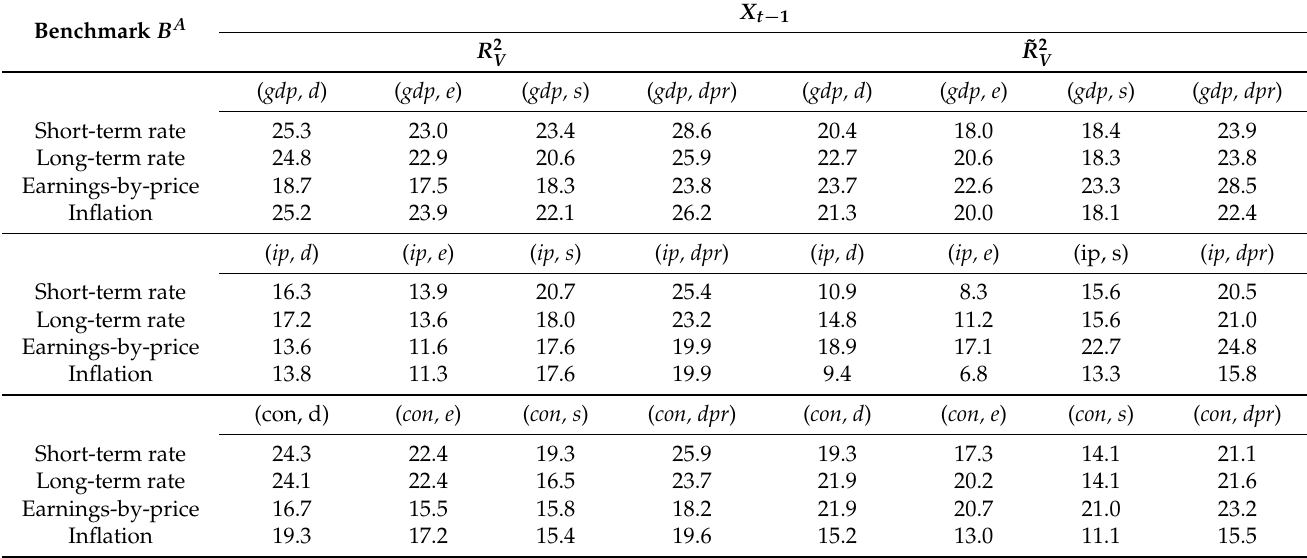
( A ) Table 6. Predictive power for the one-year excess stock returns Y in a two-dimensional setting. The prediction problem t is defined in (2). The predictive power (%) is measured by R 2 as defined in (3). The benchmarks B ( A ) considered are based V on the short-term interest rate ( A ≡ R ), long-term interest rate ( A ≡ L ), earnings-by-price ratio ( A ≡ E ), and consumer price index ( A ≡ C ). The different pairwise combinations of predictive variables, X t − 1 are given by the combination of third to fourth quarter growth rates of GDP gdp t − 1 , industrial production ip t − 1 and personal consumption expenditures con t − 1 with dividend-by-price ratio d t − 1 , earnings-by-price ratio e t − 1 , term spread s t − 1 and debt-by-price ratio dpr t − 1 . The predictive power (%) for the one-year stock returns ln S t validated on the original scale without benchmark is measured by ˜ R 2 as defined in (5) in terms of back-transformed stock return prediction (cid:100) ln S t defined in (4). The sample period V